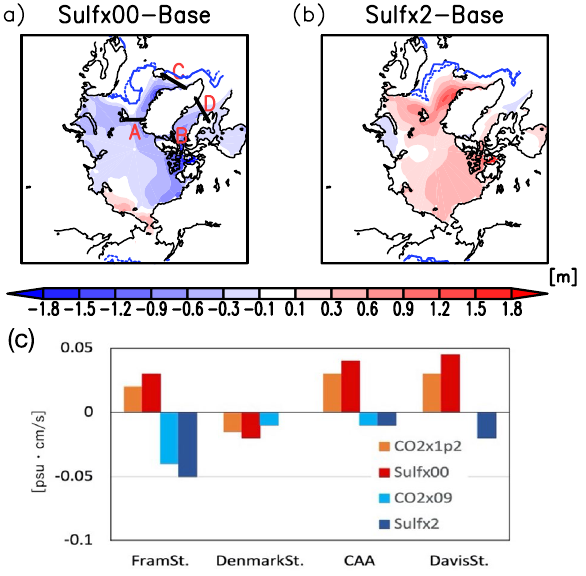
Figure 6. Anomalies of the annal mean Arctic sea ice thickness for Sulf × 00 ( a ) and Sulf × 2 ( b ) experiments from the base experiment. The dashed and solid blue lines are the locations of the annual mean sea ice thickness of 0 m in the base and each sensitivity experiments, respectively. The letters A, B, C, and D in ( a ) are the locations of the Fram Strait, Canadian Arctic Archipelago (CAA), Denmark Strait, and Davis Strait, respectively. The maps were generated with GrADS 2.2.1 (URL: http:// cola. gmu. edu/ grads/). The annual mean southward freshwater flux through each strait below 100 m depth is in ( c